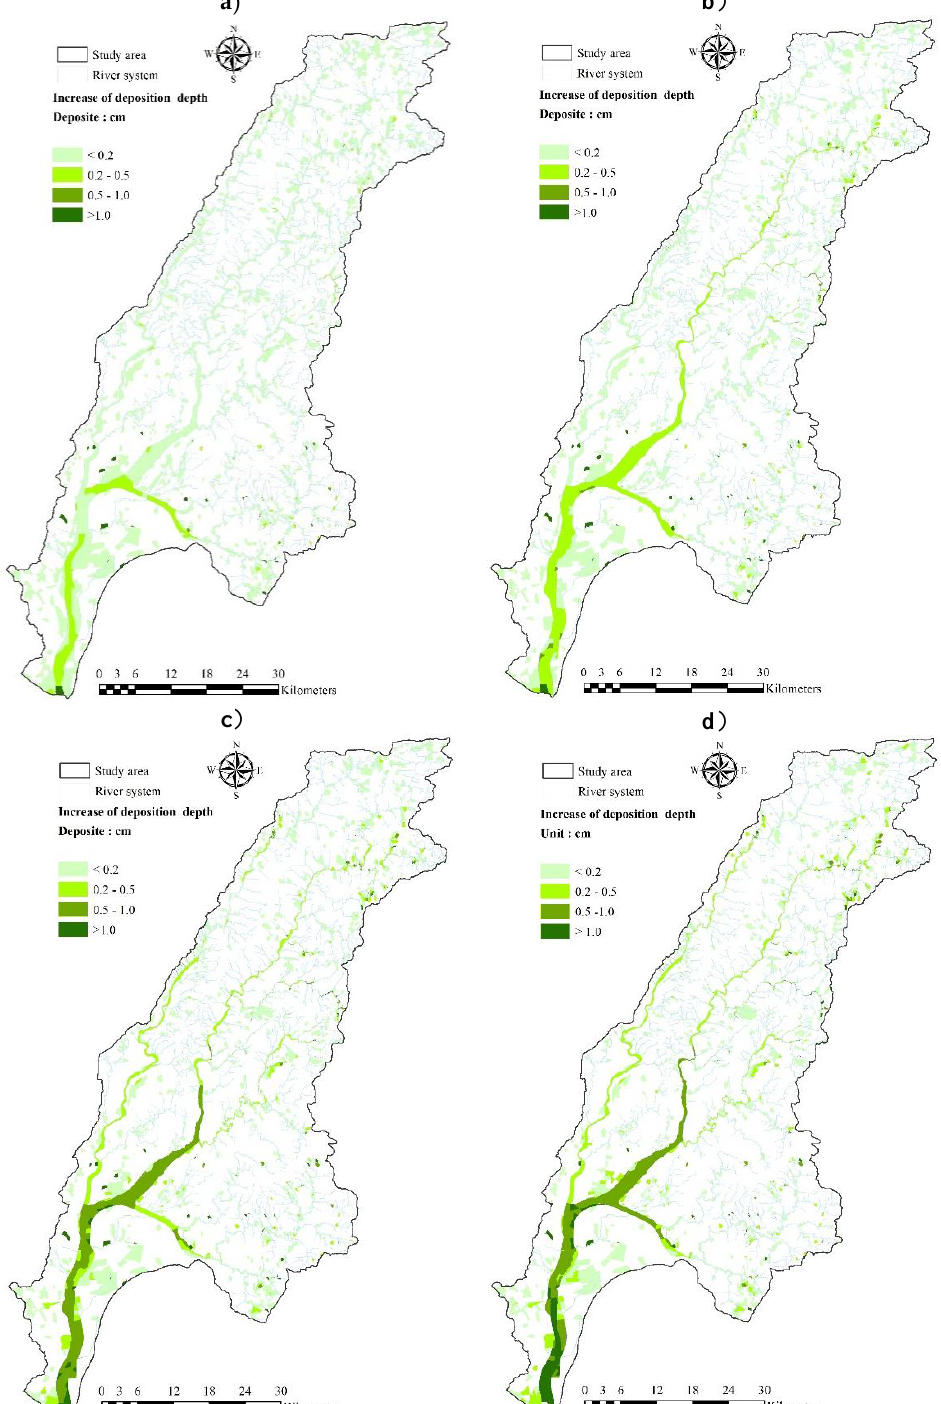
Figure 20. Spatial distribution of deposition depth increase under the influence of climate change for